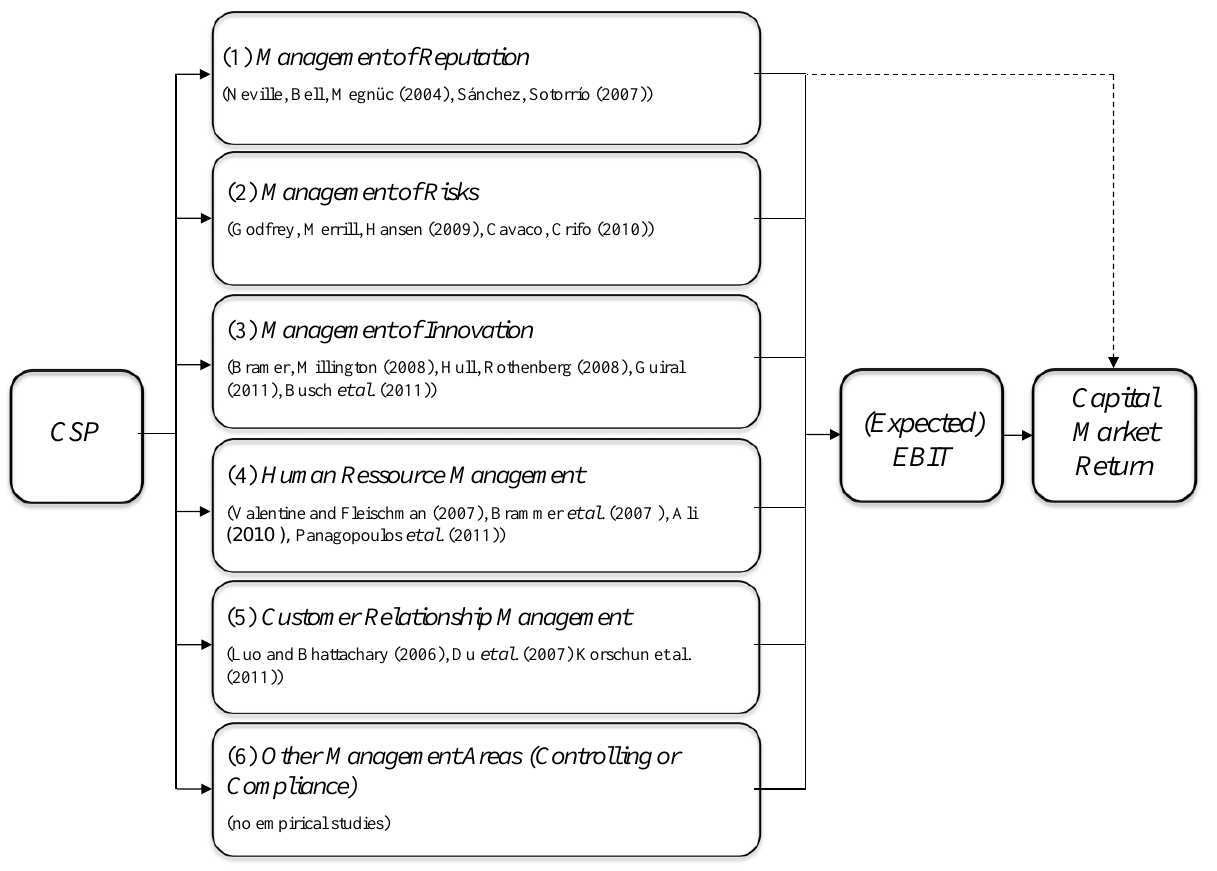
Figure 1. Micro-level empirical corporate social responsibility (CSR) research: CSR functions and the corporate social performance (CSP)-CFP relationship (own